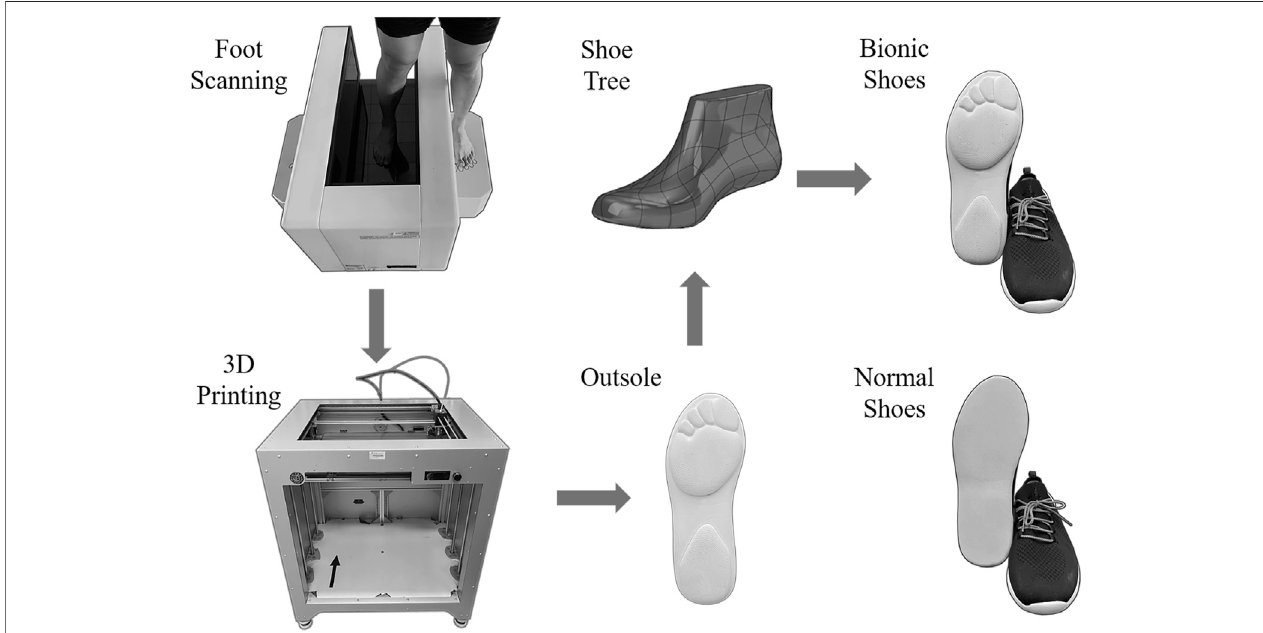
FIGURE 1 | Illustration of BS and NS making procedure from initial idea to fi nished